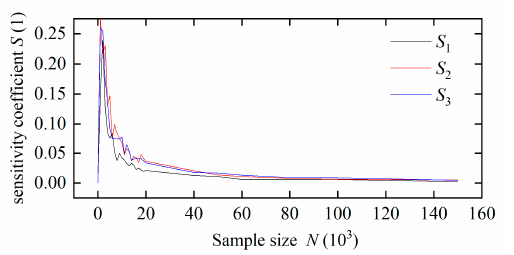
Figure 12. First-order sensitivity coe ffi cient with changing sample size. Figure 12. First-order sensitivity coefficient with changing sample size. Figure 12. First-order sensitivity coefficient with changing sample size. Figure 12. First-order sensitivity coefficient with changing sample size.